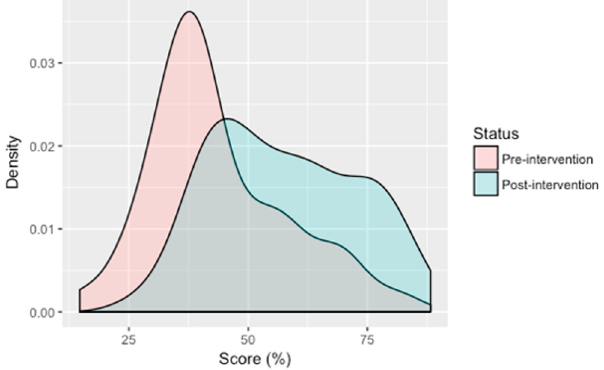
Figure 4. Density plot of pre- and post-intervention knowledge scores.